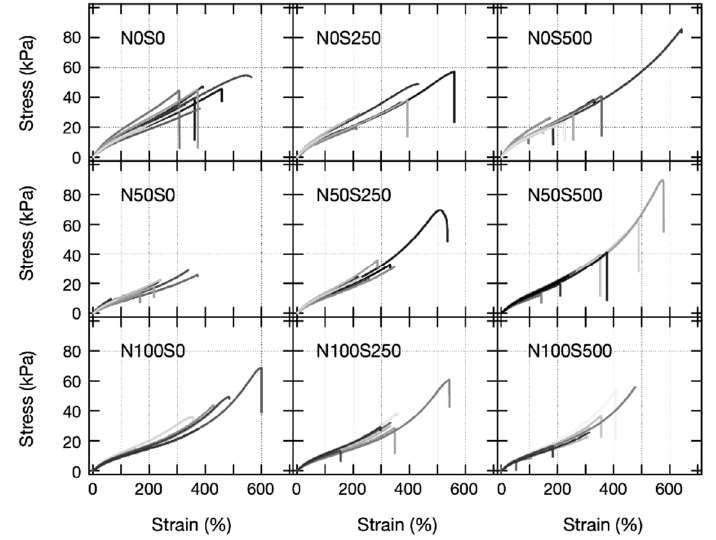
Figure 8. Stress–strain curves of the equivolume PAA gels at various neutralization and salt condi- tions. Each panel contains at least nine samples’ results.